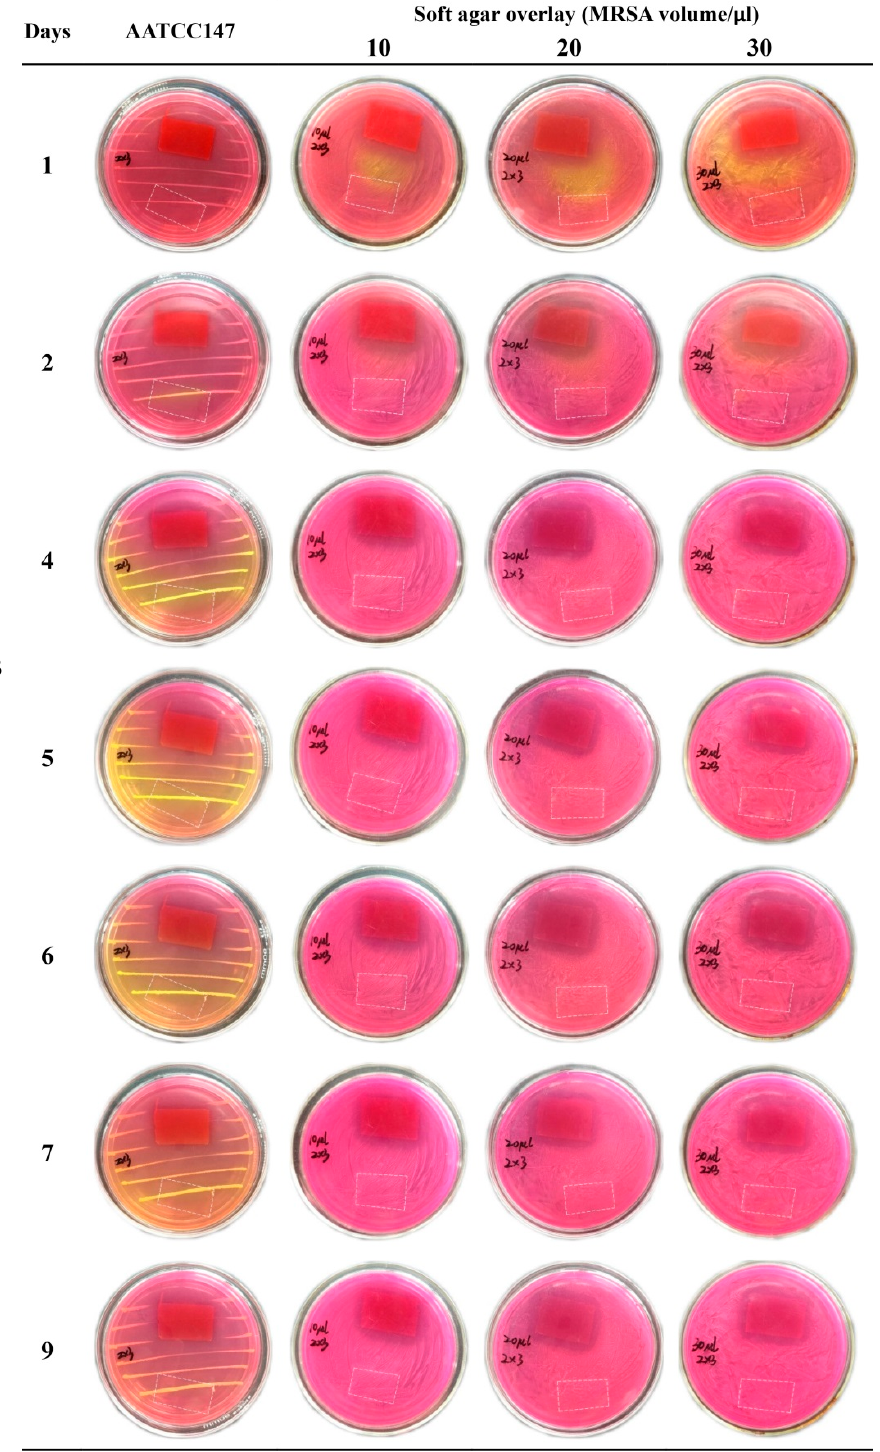
Figure 11. Evaluation of anti-MRSA of nanofiber membranes. Red membranes (( A ): 2 × 2 cm; ( B ): 2 × 3 cm) in the petri dishes: nanofibers with emodin; area marked by white dotted box (( A ): 2 × 2 cm; ( B ): 2 × 3 cm) in the petri dishes: nanofibers without emodin.